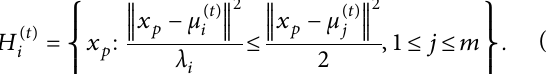
Figure 4: Iterative diagram of the